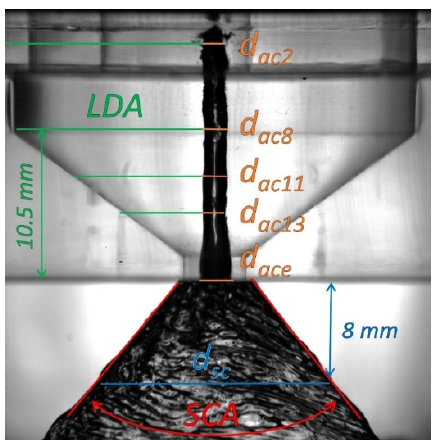
Figure 2. The typical high-speed image with measured